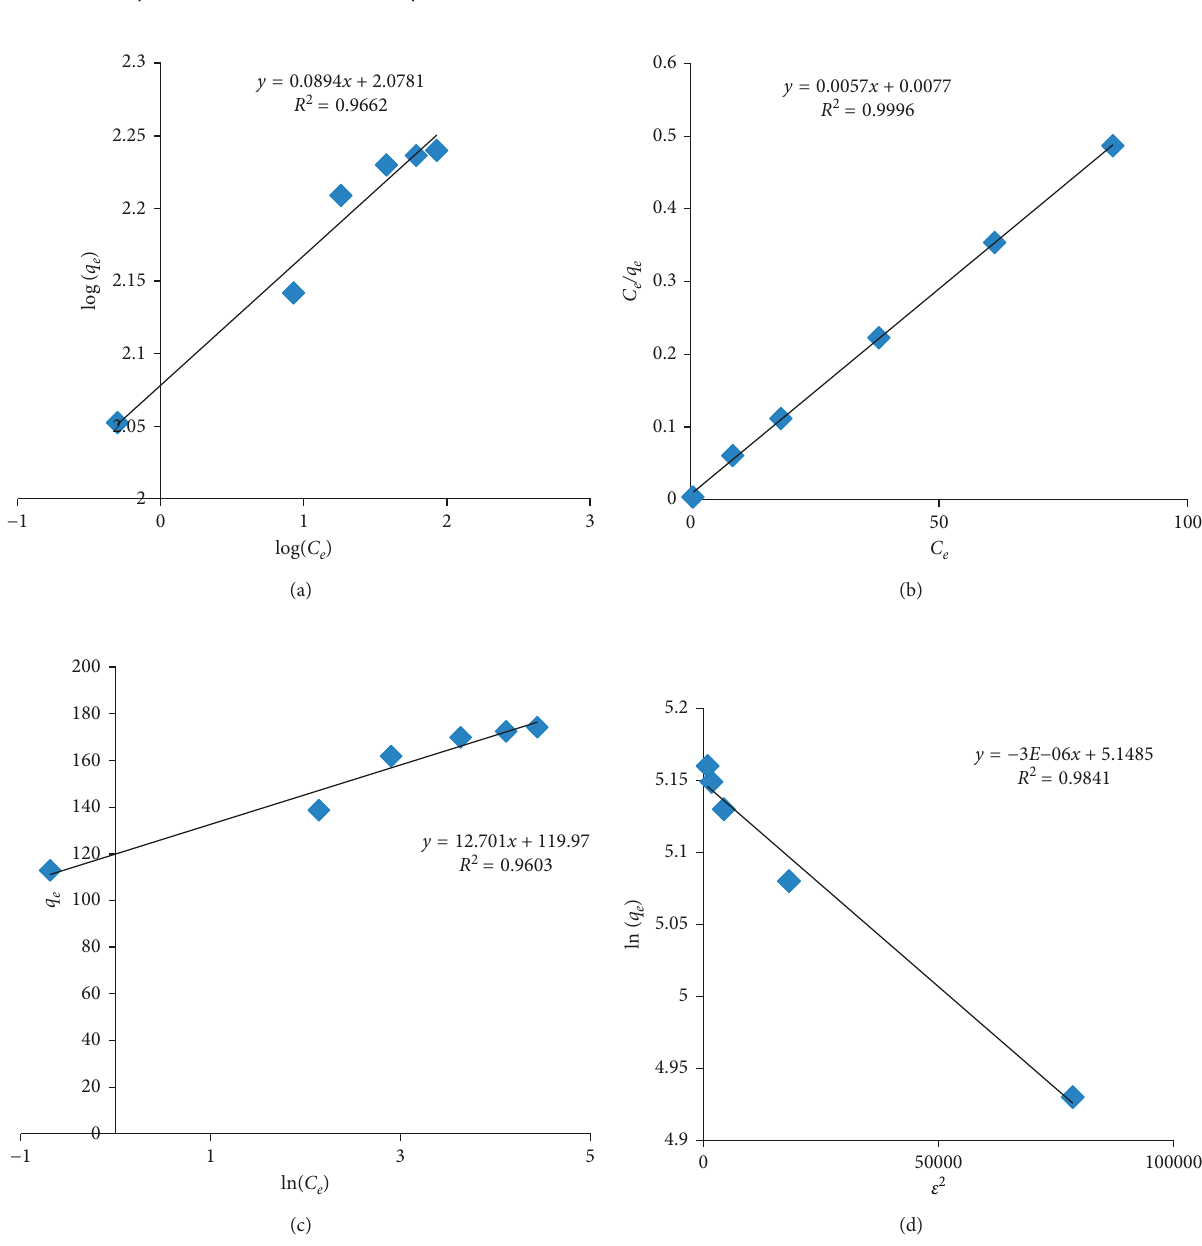
Figure 13: (a) Freundlich adsorption isotherm. (b) Langmuir adsorption isotherm. (c) Temkin adsorption isotherm. (d) Dubinin– Radushkevich adsorption